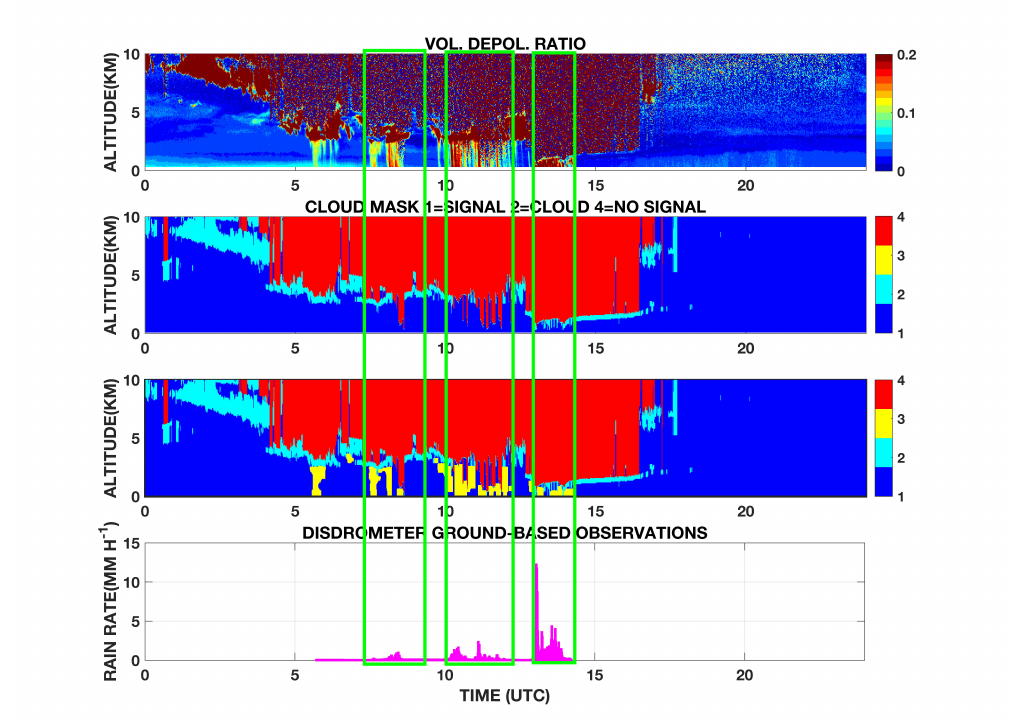
Figure 6. Similar to Figure 5, but for 12 April 2016. This case presents different short precipitation originating from the transit of a